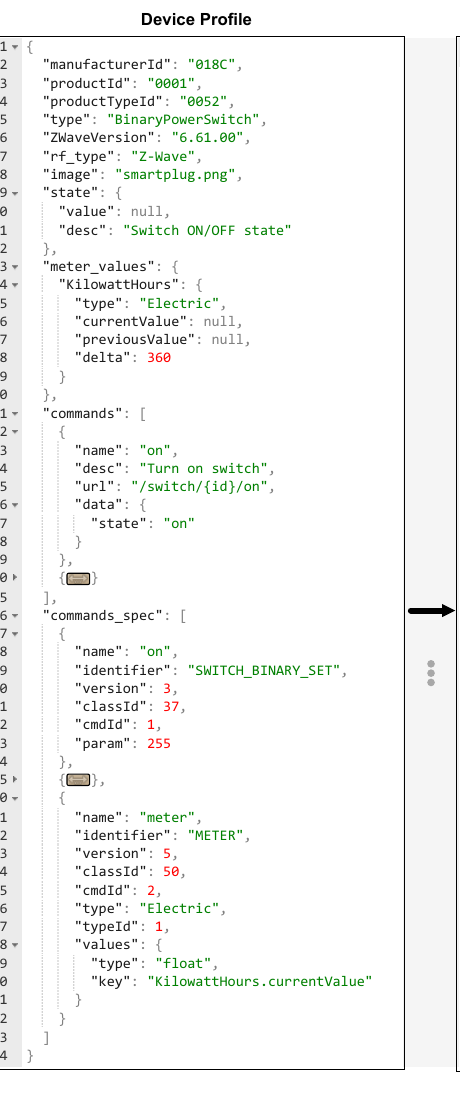
Figure 4. All information of a device is stored in the NoSQL database as a virtual